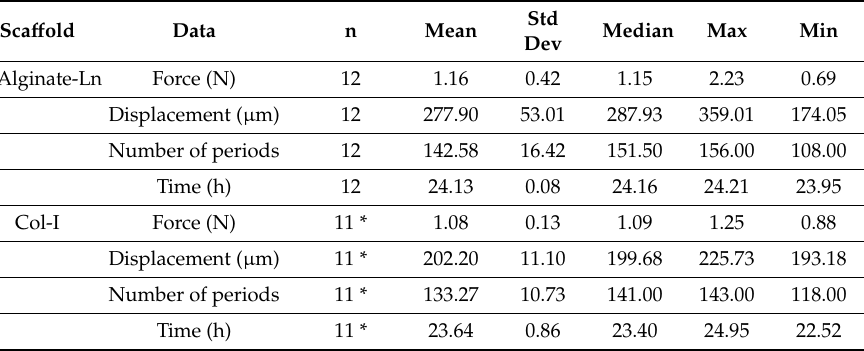
* One of the technical replicates was excluded (see Section